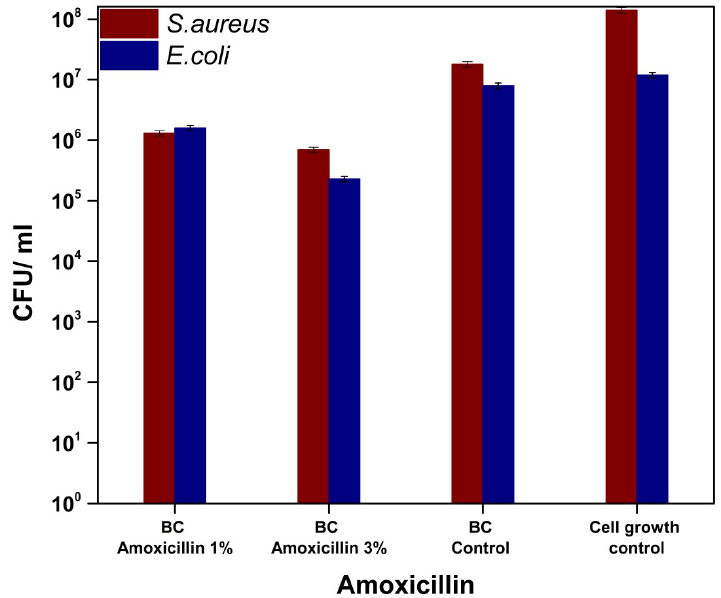
Figure 11. Graphical representation of CFU / mL values of Staphylococcus aureus ATCC 25923 and Escherichia coli ATCC 25922 in order to evaluate the capability of the bacterial cells to adhere on the surface of BC-amoxicillin samples.